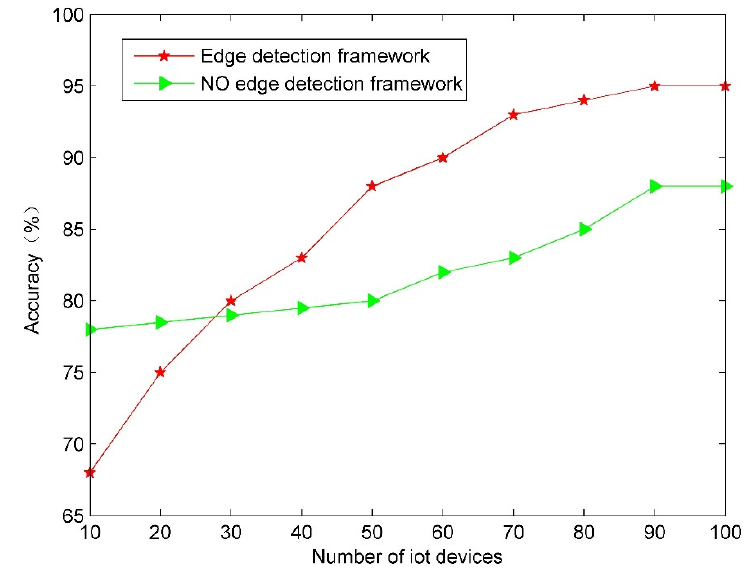
Figure 11. Comparison of detection